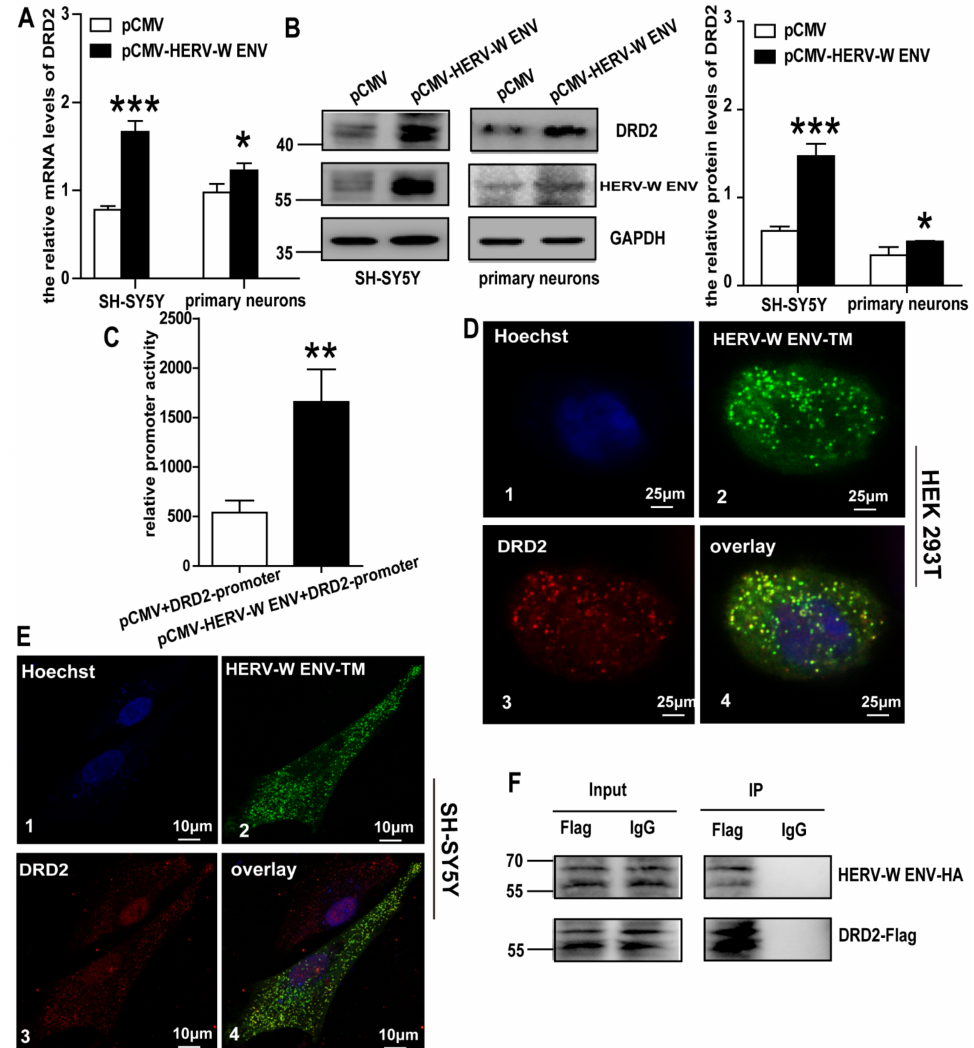
Figure 4. HERV-W ENV increases DRD2 expression by colocalizing and interacting with it: ( A ) the mRNA level of DRD2 in the HERV-W ENV overexpression group was higher than the control group in the DA neurons. ( B ) The protein level of DRD2 in the HERV-W ENV overexpression group was higher than the control group in the DA neurons. ( C ) Luciferase assays of pGL3-DRD2 promoter co-transfected with pCMV-HERV-W ENV or control vector in SH-SY5Y cells. ( D ) Three-color STED images of Hoechst, which specifically stain the nuclei (D1), HERV-W ENV-TM (D2), and DRD2 (D3) in HEK293T cells (D4). Three-color overlay STED images of Hoechst, pEGFP-HERV-W ENV-TM , and pENTER-DRD2 in HEK293T cells. ( E ) Three-color STED images performed as in Figure 4D in SH-SY5Y cells. ( F ) Co-IP results shown in the DRD2-Flag-IP group could show the HERV-W ENV-HA band but could not show such in the negative control, which demonstrated the interactions between each other. * p < 0.05, ** p < 0.01, *** p <